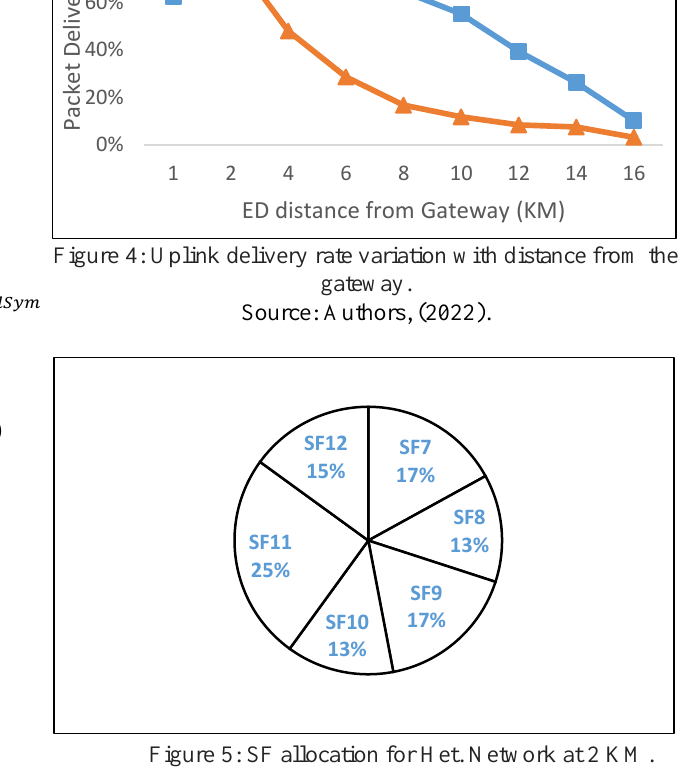
Figure 5: SF allocation for Het. Network at 2 KM.